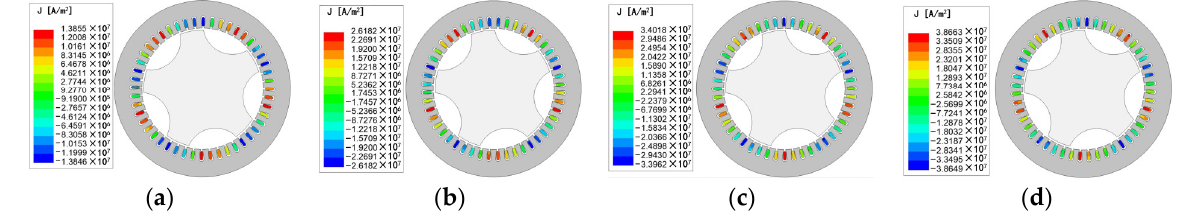
−− −− −− Figure 15. Air-gap flux density distribution under different slip speed at 6A excitation current. Figure 15. Air-gap flux density distribution under different slip speed at 6A excitation current. Figure 15. Air-gap flux density distribution under different slip speed at 6A excitation current. Figure 15. Air-gap flux density distribution under different slip speed at 6A excitation current.